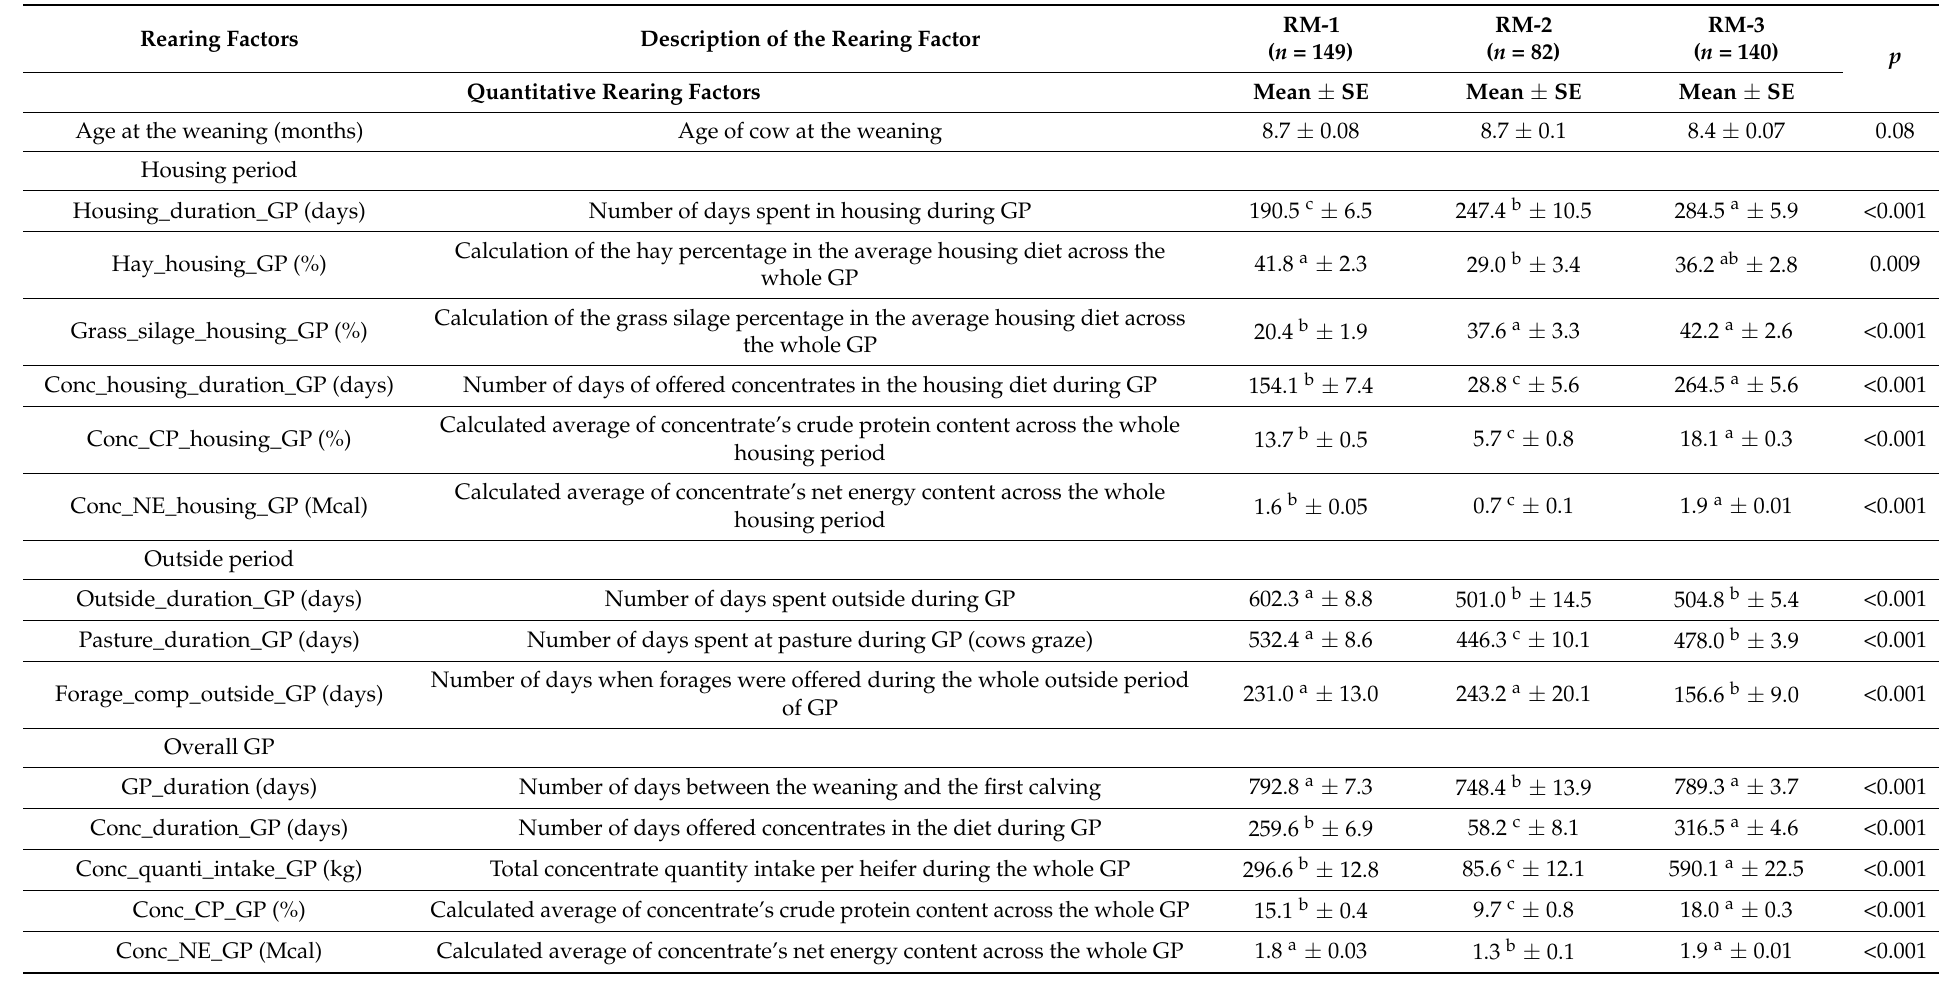
Table 4. Rearing factors characterizing the growth period (GP) of the rearing managements (RM) applied during the cull cows’ whole